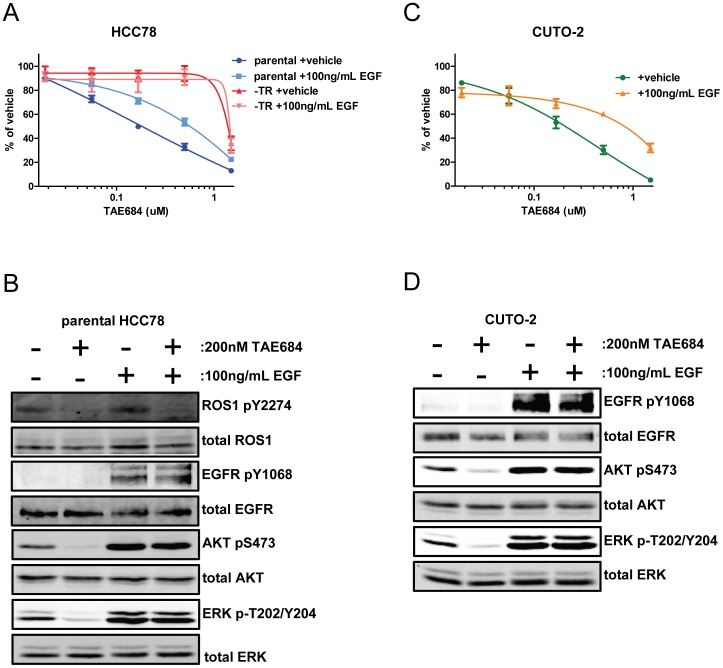
EGF stimulation desensitizes parental HCC78 cells and CUTO-2 cells to ROS1 inhibition.(A) Parental HCC78 and HCC78-TR cells were treated with TAE684 for 3 days with or without the addition of 100ng/mL EGF and then analyzed by MTS assay. Values represent the mean ± SEM (n = 3). Calculated IC50 values for TAE684: parental+vehicle = 0.18 µM, parental+EGF = 0.57 µM, HCC78-TR+vehicle = 1.39 µM, and HCC78-TR+EGF = 1.45 µM. EGF significantly desensitized parental HCC78 but not HCC78-TR cells to TAE684 as determined by student’s paired t-test (p<0.05). (B) Parental HCC78 cells were treated with TAE684 for 4 hours, EGF for 10 minutes, or a combination of both. Lysates of the cells were then analyzed by Western blot using the indicated antibodies. (C) CUTO-2 cells were treated with TAE684 for 4 days with or without the addition of 100ng/mL EGF and then analyzed by MTS assay. Values represent the mean ± SEM (n = 3). Calculated IC50 values for TAE684: +vehicle = 0.2 µM and +EGF = 0.81 µM. EGF significantly desensitized CUTO-2 cells to TAE684 as determined by student’s paired t-test (p<0.01). (D) CUTO-2 cells were treated with TAE684 for 4 hours, EGF for 10 minutes, or a combination of both. Lysates of the cells were then analyzed by Western blot using the indicated antibodies. Phosphorylated ROS1 bands were below the limit of detection and were therefore not included.